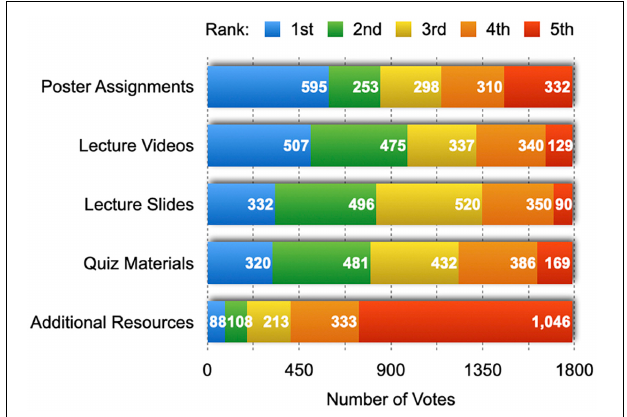
FIGURE 3 | Students ranked five course components (Poster Assignments, Lecture Videos, Lecture Slides, Quiz Materials, Additional Resources) based on which component they learned the most (1st) to least (5th). Total number of votes that each component received is shown as blue (1st-place), green (2nd-place), yellow (3rd place), orange (4th-place), red (5th-place). A total of 1,788 students from three different asynchronous, online courses participated. Students completed rankings at the end (i.e., Week 15) of the Autumn 2020, Spring 2021, and Autumn 2021 semesters after they had completed all lectures, quizzes and poster assignments. All student responses were